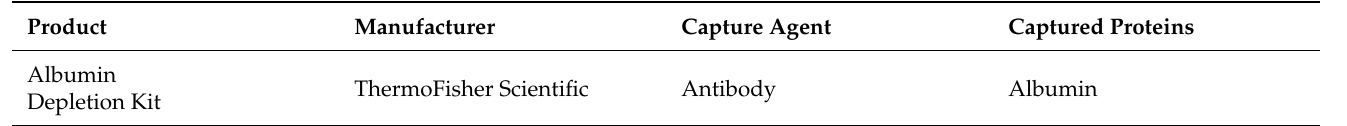
Table 2. List of commercially available products for high-abundance protein depletion or low- abundance protein enrichment of serum and plasma